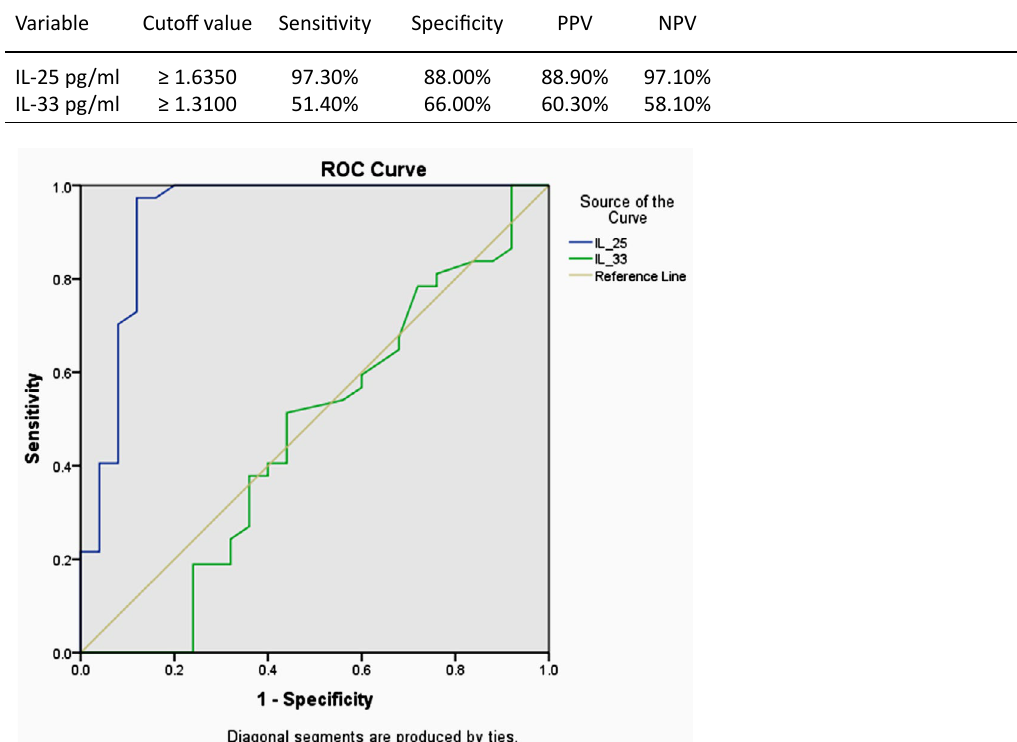
Fig. 1. ROC curves for optimal cutoff points at which IL-25 and IL-33 discriminate asthmatic patients from non asthmatic